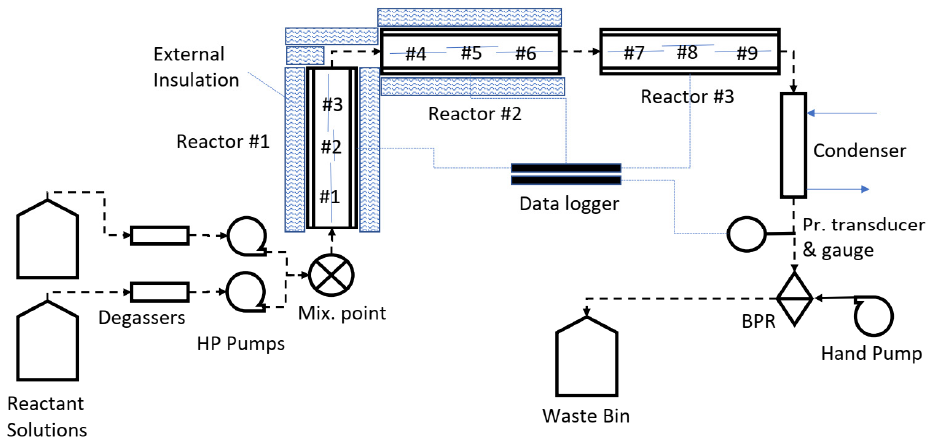
Figure 2. Flow diagram of the three reactors, flow-through testing facility. Three samples were accommodated in each reactor.